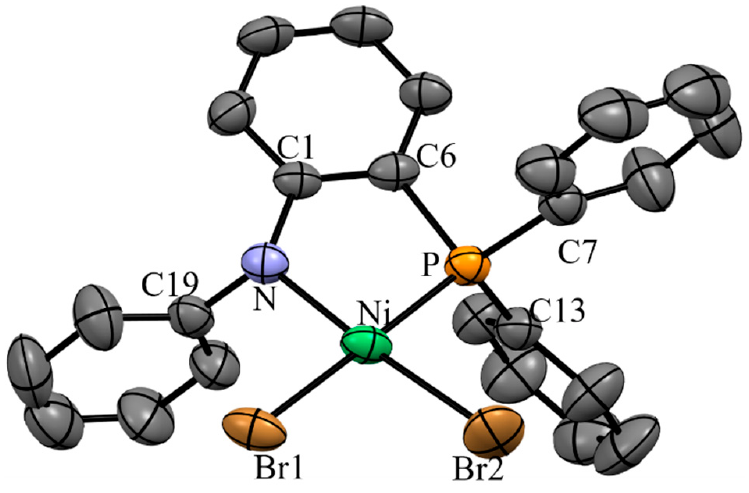
Figure 1. Oak Ridge thermal ellipsoid plot (ORTEP) representation of complex Ni1 (50% thermal ellipsoids). Hydrogen atoms are removed for clarity. Selected bond lengths (Å) and angles (deg): Ni1 − P1 2.1375(13), Ni1 − N1 1.973(4), Ni1 − Br1 2.3625(8), Ni1 − Br2 2.2979(8), N1 − Ni1 − P1 87.87(11), Br1 − Ni1 − Br2 93.08(3).